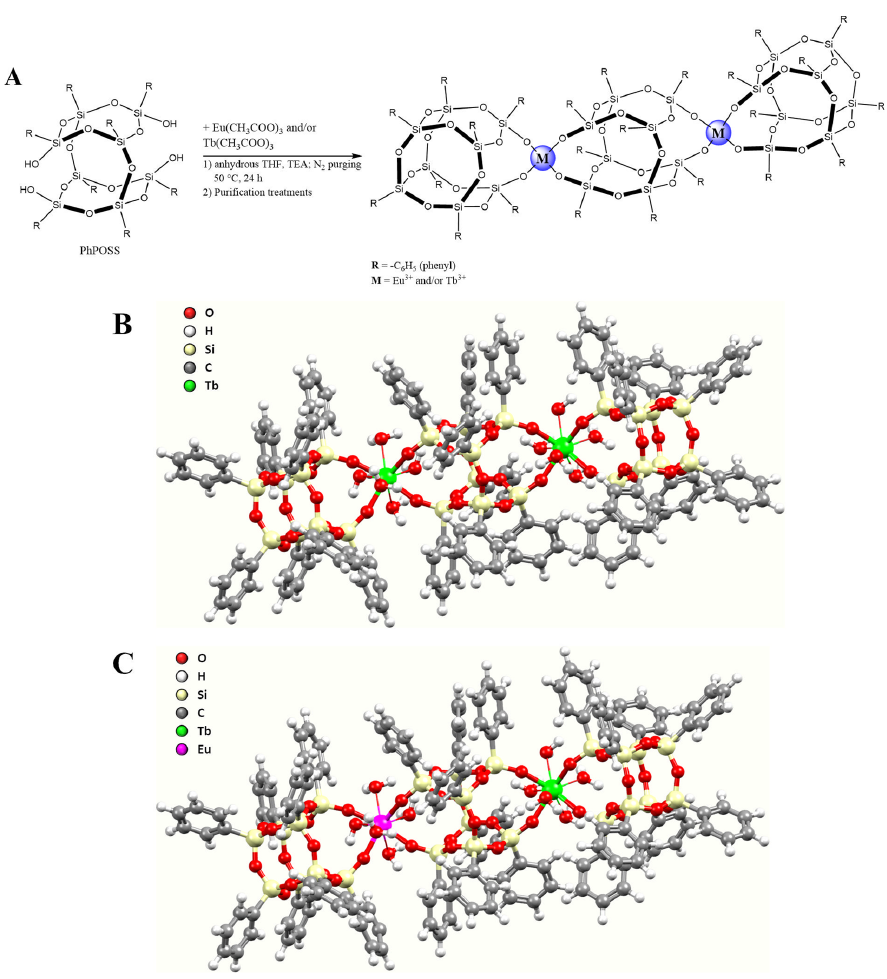
Figure 1. ( A ) Synthesis of metal-containing PhPOSS. Schematic view of a possible structure of Tb-PhPOSS ( B ) and TbEu-PhPOSS ( C ).